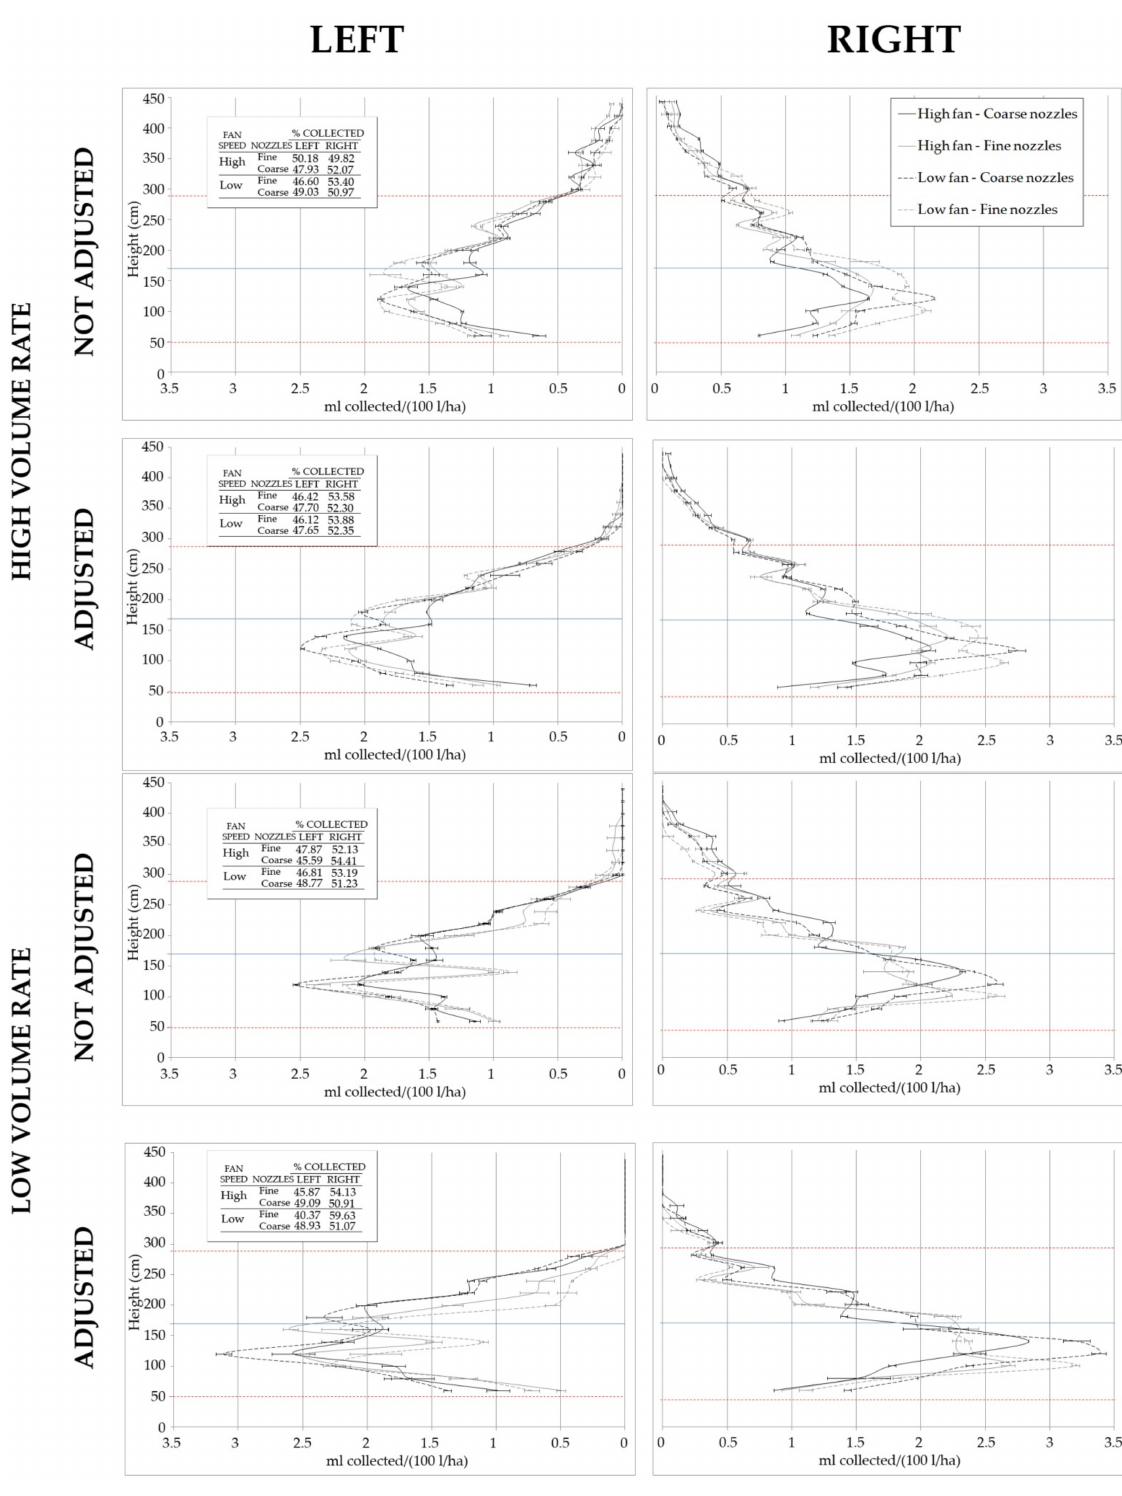
Figure 8. Vertical spray profiles showing the normalized volume collected by the patternator (mL/(100 L/ha) (mean ± Standard error (SE)) at different heights above the ground (m), for the applications with the T sprayer . The percentage collected on each side of the sprayer respect to the total volume collected for each configuration is shown. The red dashed lines represent the upper and the lower limit of the canopy target, and the blue line its middle